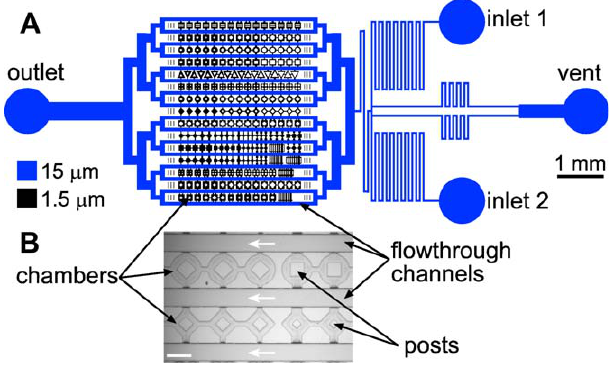
Figure 1. Microfluidic Device (A) A drawing of the microchannels; microchannels with depths of 15 and 1.5 l m are shown in blue and black. (B) A micrograph of a fragment of the array of channels and chambers. White arrows indicate the direction of flow. Scale bar, 100 l m. See a magnified view of the central part of the device in Figure P1 of Protocol